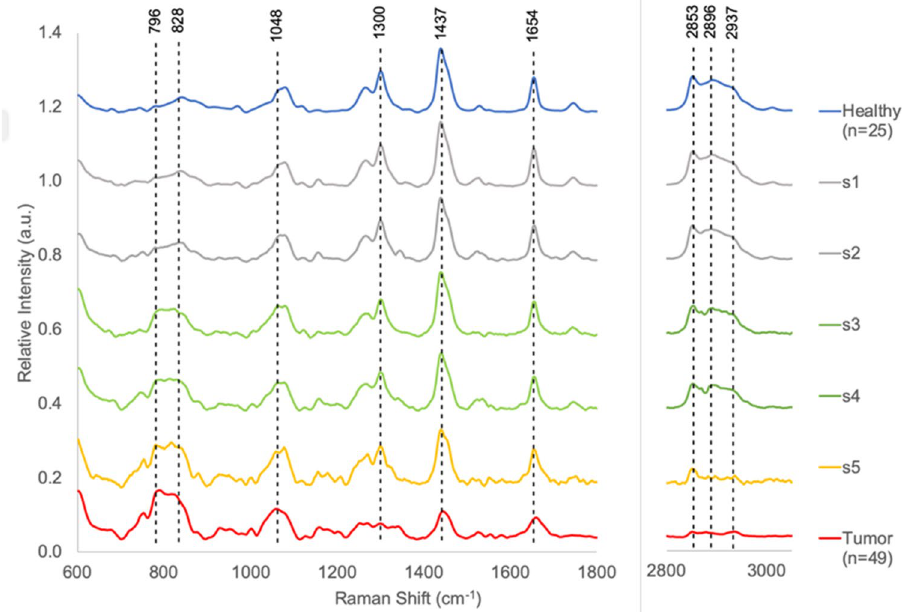
Figure 4. Disagreement between Histopathology and k-means. Spectra s1 to s4 were acquired form H&E regions assessed to be 100% tumor by histology, but were assessed by k-means to be most similar to healthy spectra. The results were the same for all 3 feature sets (FP, HW, and FPHW). Spectrum s5 was also obtained from a region assessed as 100% infiltrated with tumor tissue by H&E analysis. The spectrum was classified by k-means as cancerous when using HW and FPHW data sets, but was classified as healthy when using the FP feature set. Spectra s1 and s2 (gray) are most similar to the average healthy spectrum shown in Fig. 1 and reproduced here at the top of the graph (blue). The similarity is evident both to qualitative visual inspection and the two spectra appear at the heart of the k-means cluster for healthy spectra. Healthy features include the relatively weak RNA|DNA backbone and protein signal at 796 and 828 cm −1 , respectively with and the strong signal in HW. Spectra s3 and s4 (green) show characteristics of both healthy and tumor spectra. The RNA|DNA backbone and protein signals are increasing with the signal at 796 cm −1 increasing relatively more than the 828 cm −1 band, but the strong signal in HW remains. Spectra s5 (gold) is most similar to the average cancer spectra. Here the HW signal as collapsed and nucleotide and protein signals have increased, but the band intensity ratio for 796/828 has not shifted to favor the nucleotide moiety as it has in the average tumor spectrum (red) at the bottom of the